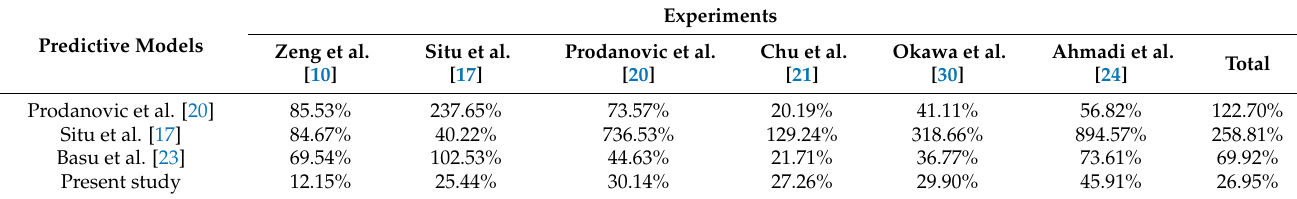
Table 3. Evaluated relative errors between the models and the